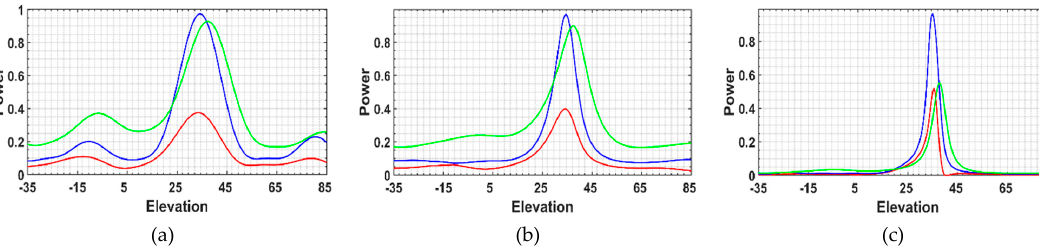
Figure 5. Span profiles of ground ( a ) and forest ( b ) pixels. Cyan, blue, and red are indicative of Beamforming, Capon, and the proposed method, respectively. Figure 6. Extracted three-component features of ground pixel (shown in Figure 4 a ) from reconstructed T using ( a ) Beamforming, ( b ) Capon, and ( c ) the proposed method. Red, green and blue indicate the double-bounce, volumetric and surface scattering mechanisms.